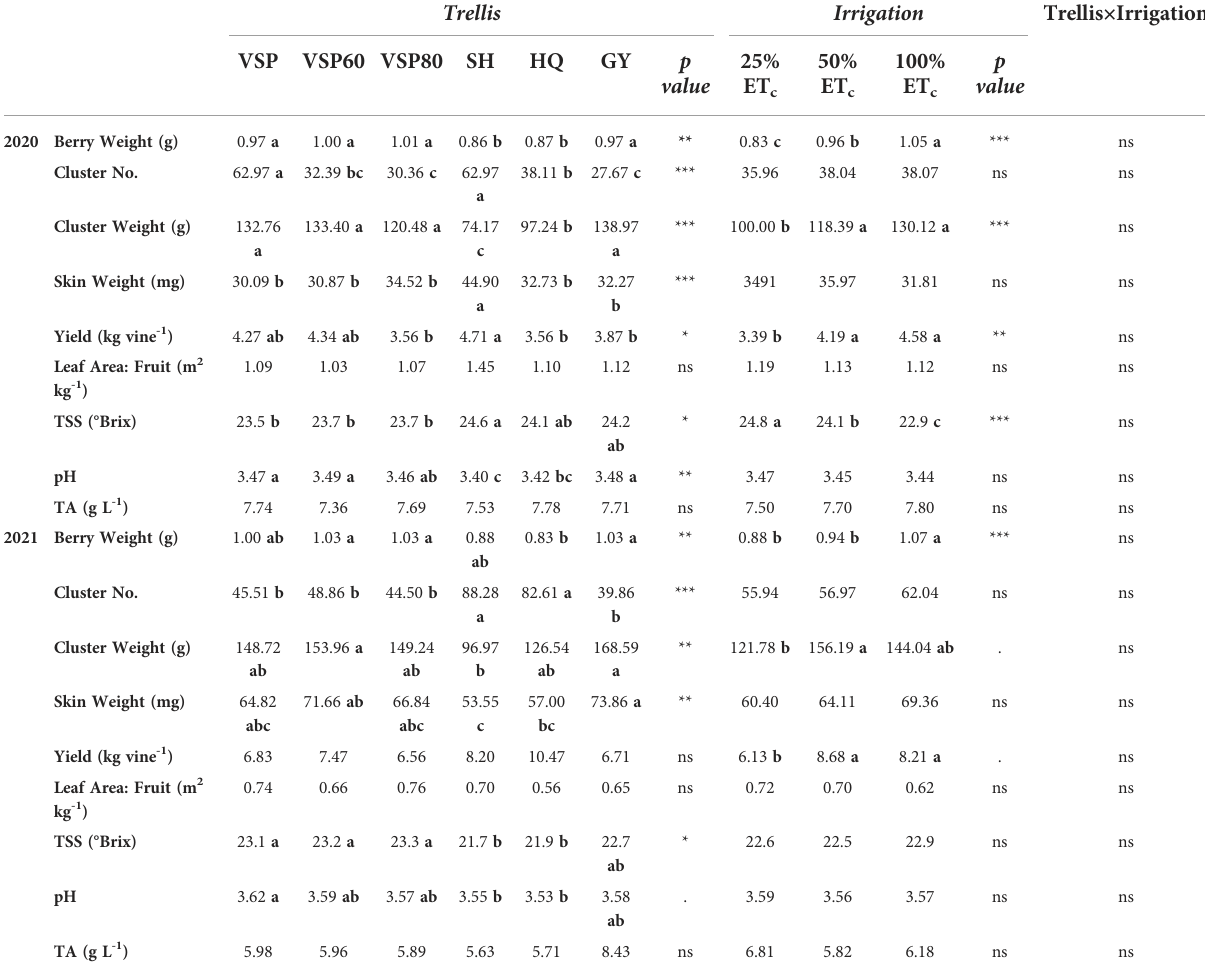
TABLE 2 Effects of trellis systems and applied water amounts on yield components and berry composition of ‘ Cabernet Sauvignon ’ in Oakville, CA in 2020 and 2021 a ,b .